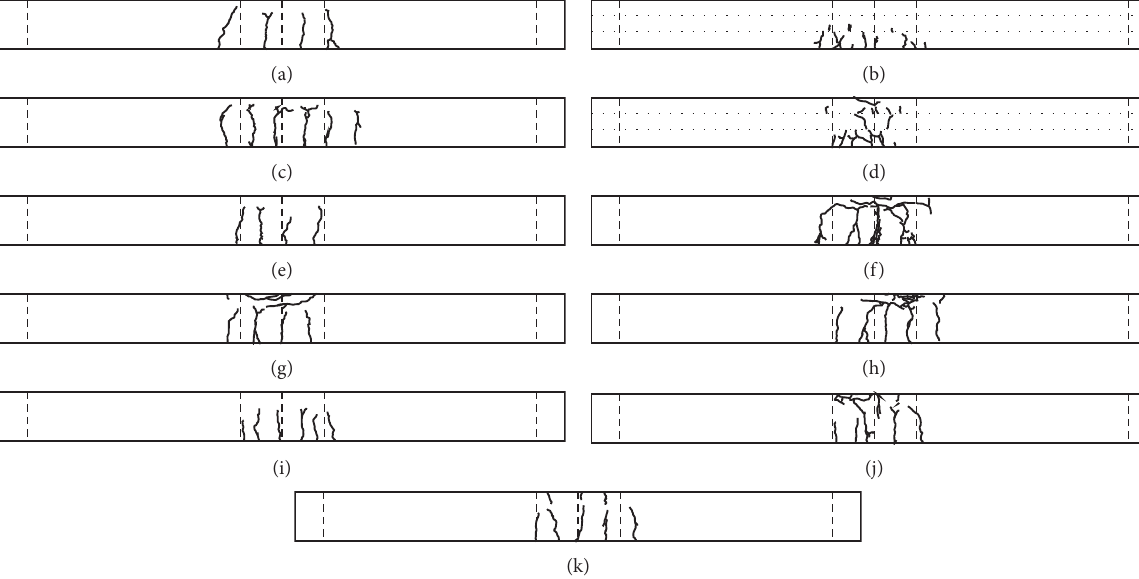
Figure 6: Crack patterns of specimens. (a) HRP-1; (b) HIP-1; (c) GRP-1; (d) GIP-1; (e) HRP-2; (f) HRP-3; (g) HRS1-3; (h) HRS2-3; (i) HRP- 4; (j) HRS1-4; and (k)